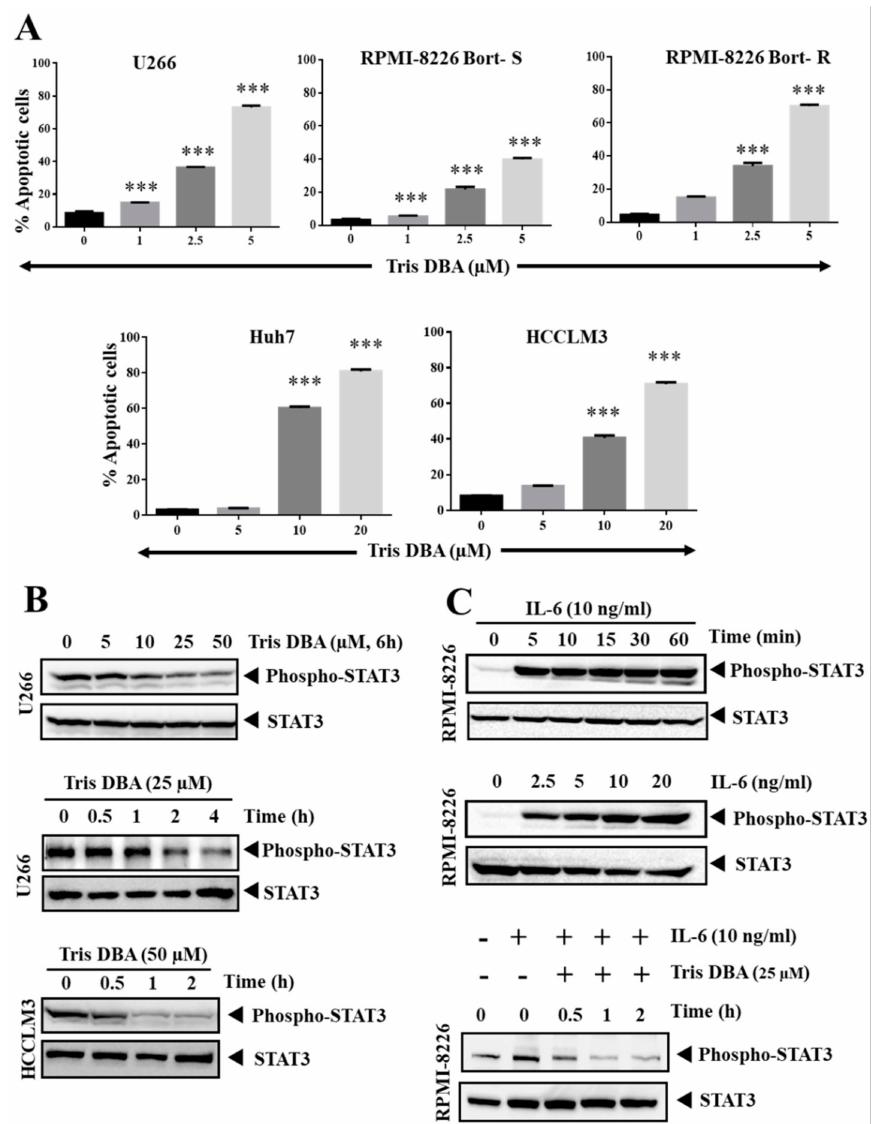
Figure 2. Tris DBA induces apoptosis and mitigates the STAT3 activation. ( A ) MM (U266, and RPMI-8226) and HCC (Huh7 and HCCLM3) cells were treated with Tris DBA and treated with FITC- Annexin V and PI to quantify the early and late apoptotic cells. Bars indicate standard deviation; n = 3; *** p < 0.001 versus no treatment. ( B ) U266 and HCCLM3 cells were exposed to Tris DBA at indicated concentrations and time points and cell lysates were used for SDS-PAGE and Western blotting to analyze phospho-STAT3/STAT3 expression. ( C ) RPMI-8226 cells were incubated with Tris DBA (25 µ M) at given time points and induced with IL-6 (10 ng/mL). The cell lysates were used for SDS-PAGE and Western blotting to analyze phospho-STAT3/STAT3